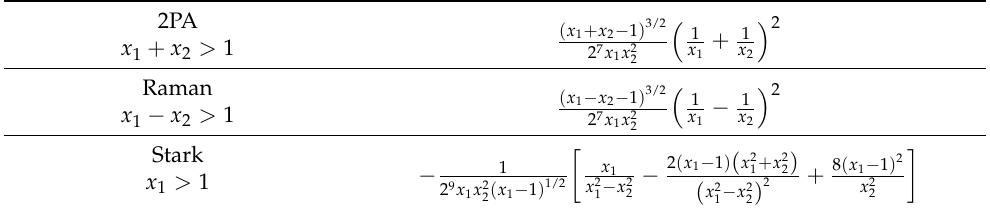
Table 2. Nonlinear absorption spectral function F 2 ( x 1 ; x 2 ) for two-photon absorption (2PA), Raman, and optical Stark